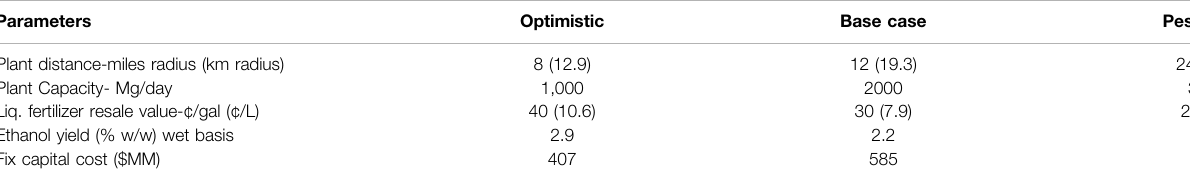
TABLE 4 | Sensitivity analysis parameters for FW fermentation process integrated with CHP. Parameters